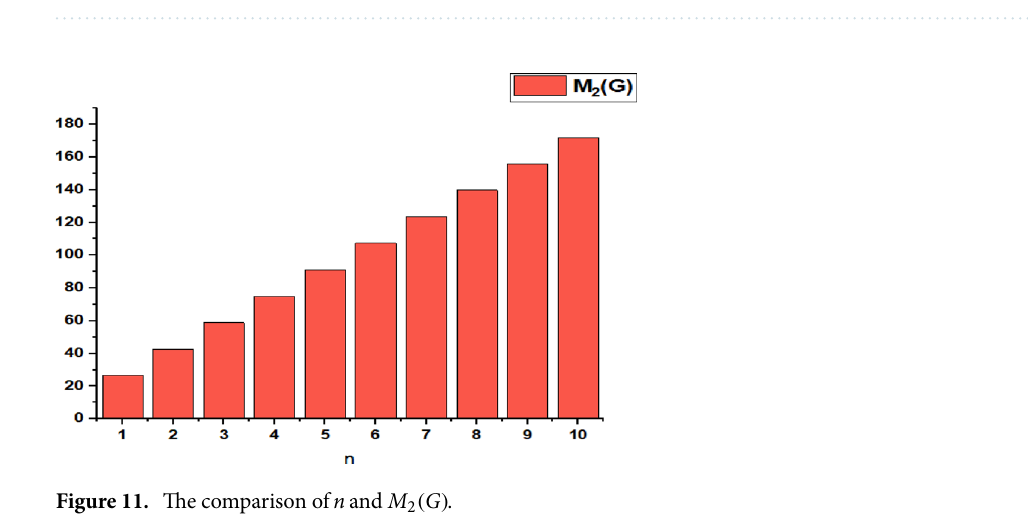
Figure 10. Comparison of topological indices for various values of n in ZNOX .